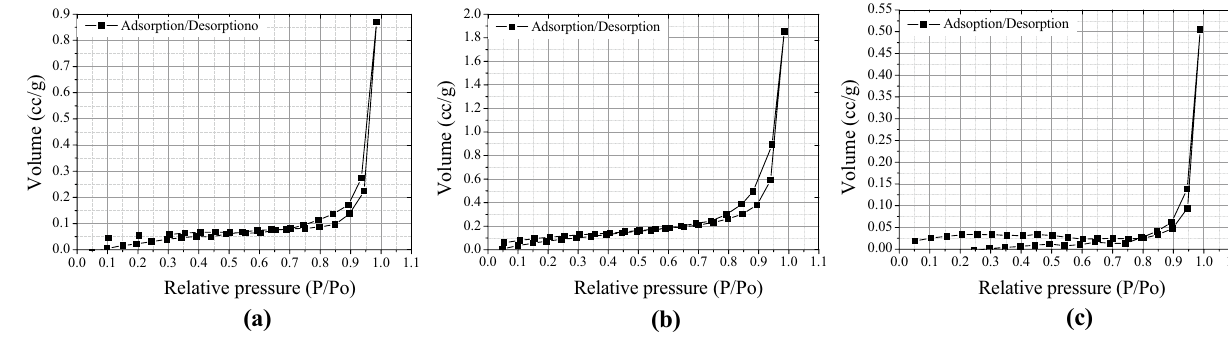
Fig. 5 Adsorption and desorption isotherms of BET to CNS chemically modified with NaOH ( a ), H